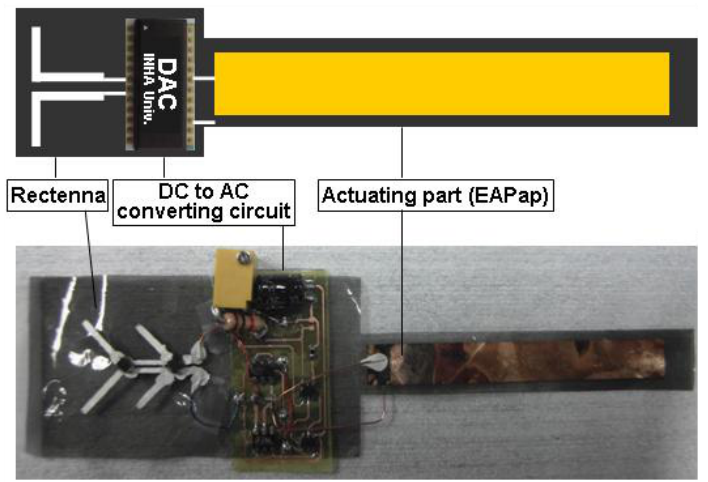
Figure 9. Configuration of Microwave driven EAPap